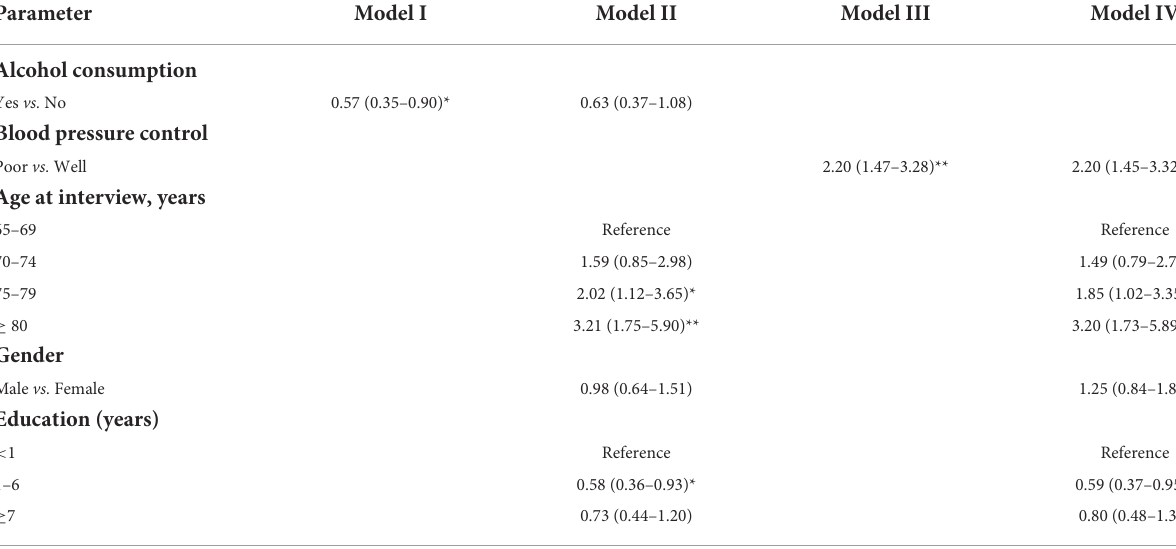
TABLE 3 Logistic regressions of risks factors for PSD in 830 stroke survivors: OR (95%